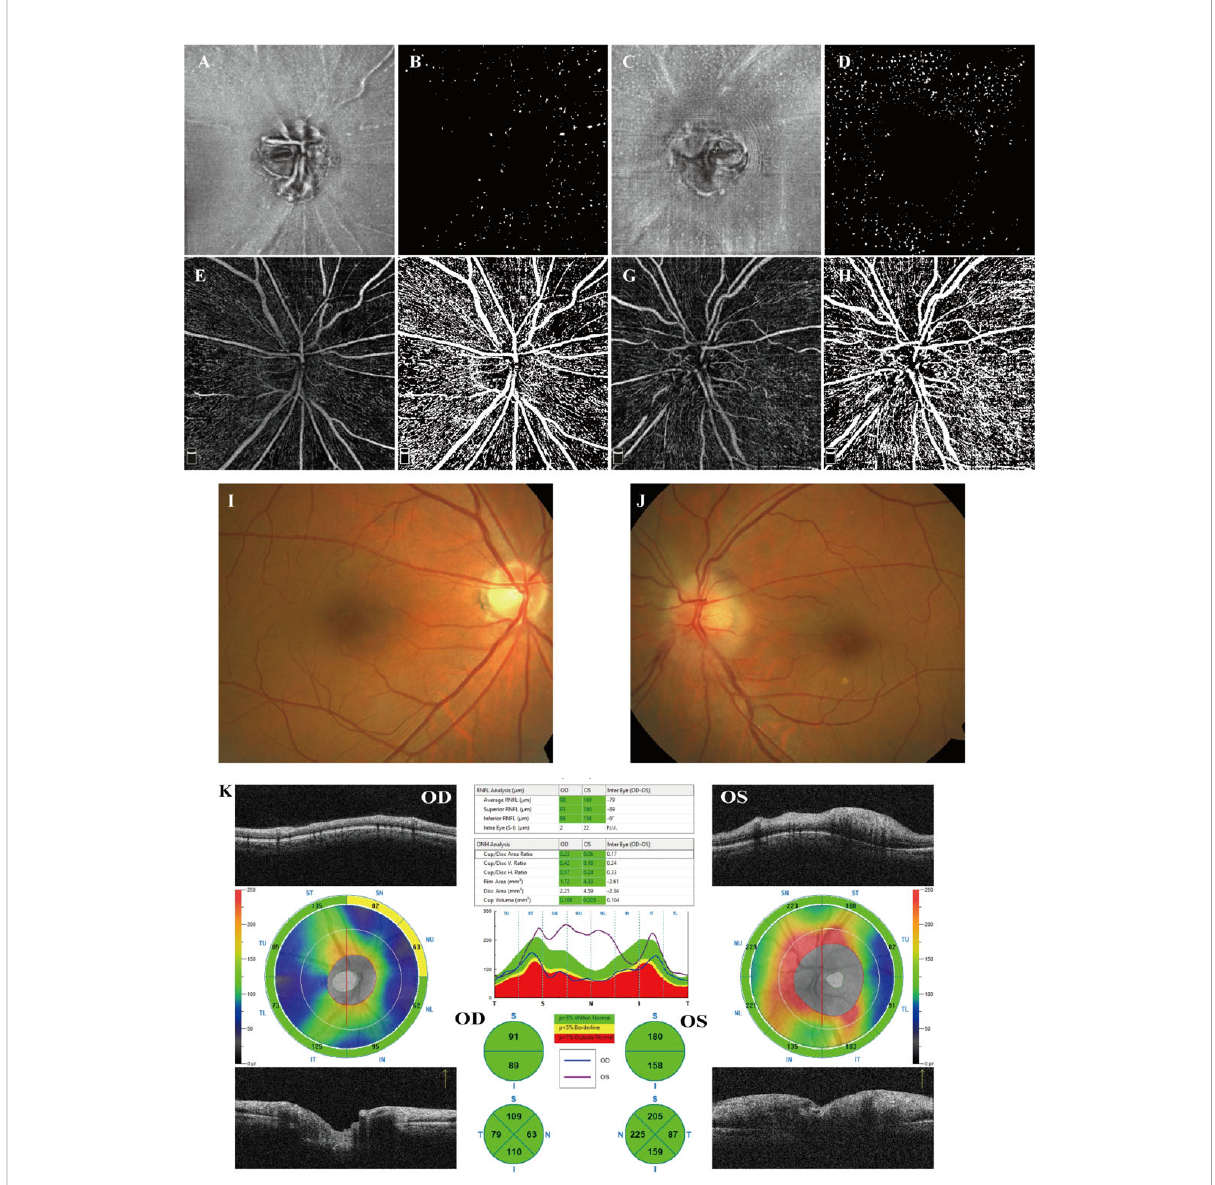
FIGURE 5 Examples from a 58-year-old male patient who suffered from a sudden visual decrease in the left eye within 2 weeks and was diagnosed with acute NAION. (A, B) en face OCT slab of MLCs from the normal right eye and its binarized image for MLC counting. (C, D) en face OCT slab of MLCs from the affected left eye and its binarized image for MLC counting. Compared to (B) , cells in (C) increased signi fi cantly, particularly in the superior sector. (B, D) More MLCs are found in the nasal ONH in both affected eye and fellow eye. (E, F) OCTA image of RPC from the right eye and its binarized image adjusted by Huang thresholding for VD measurement. (G, H) OCTA image of RPC from the left eye and its binarized image for VD measurement. In the affected eye, the loss of RPC was mainly identi fi ed as superior. (I, J) Color fundus photograph showing papilledema and retinal vascular tortuosity in the left eye. (K) The peripapillary RNFL thickness analysis illustrated that RNFL thickness increased signi fi cantly in the affected eyes, particularly in the superior, inferior and nasal